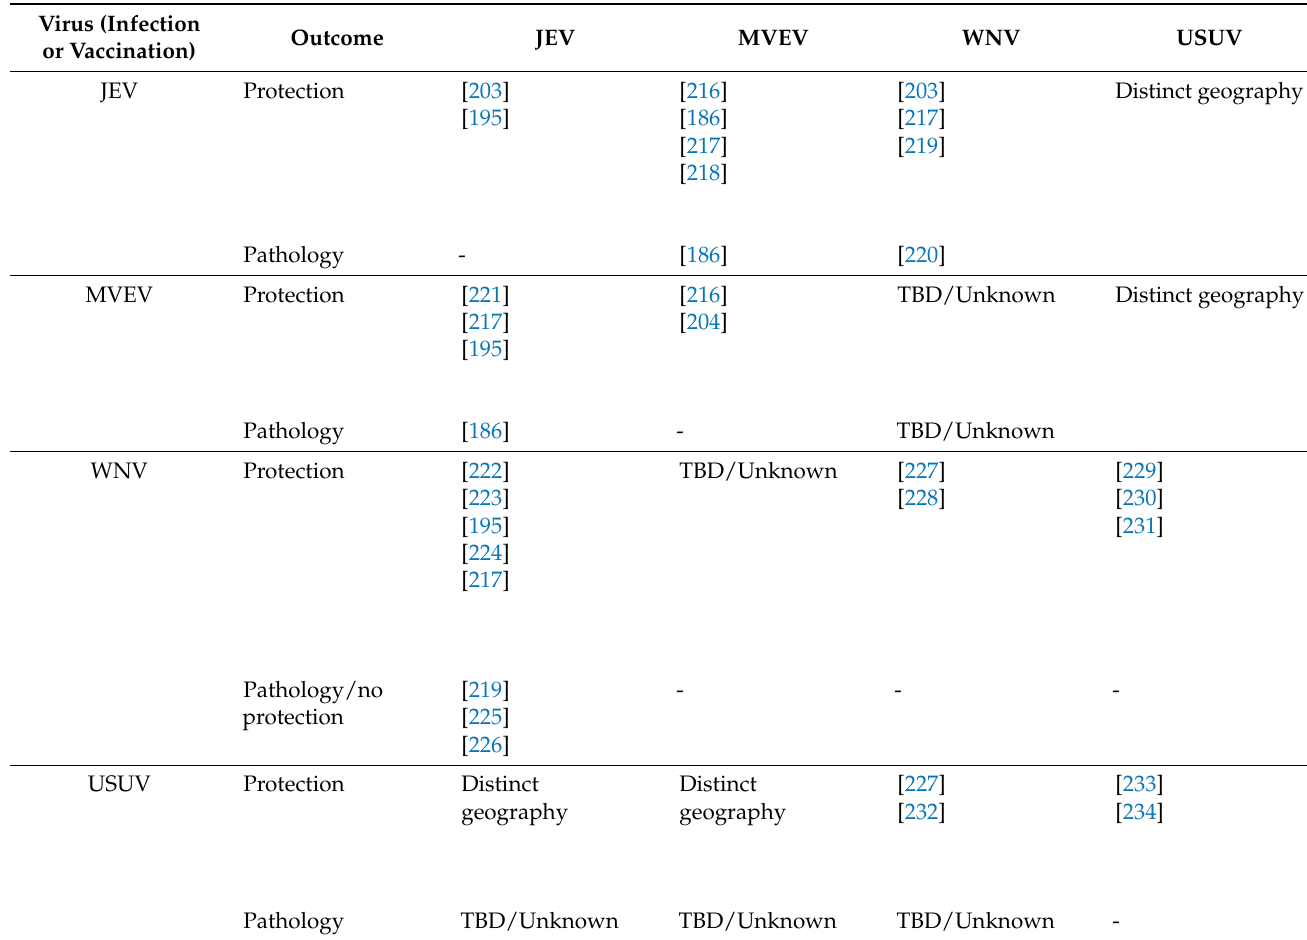
Table 3. Cross-reactivity among the four JE serocomplex viruses, JEV, MVEV, WNV and USUV, and the outcomes for disease are depicted. Viruses listed across represent preexisting immunity, primary challenge or vaccination and viruses down the column represent secondary infection. Flaviviruses circulating in distinct areas with no currently reported co-existence are denoted by ‘Distinct